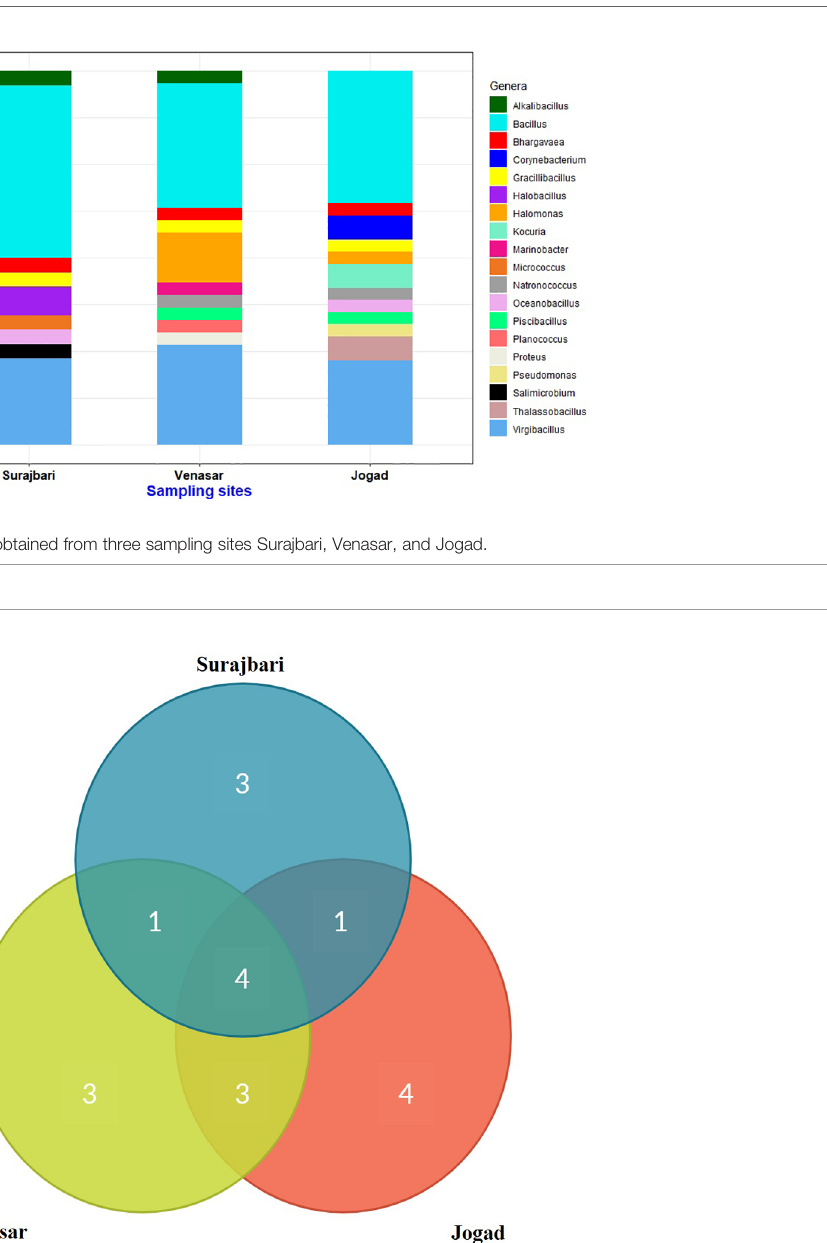
FIGURE 8 | Venn diagram representation of shared and unique genera across three different study sites of